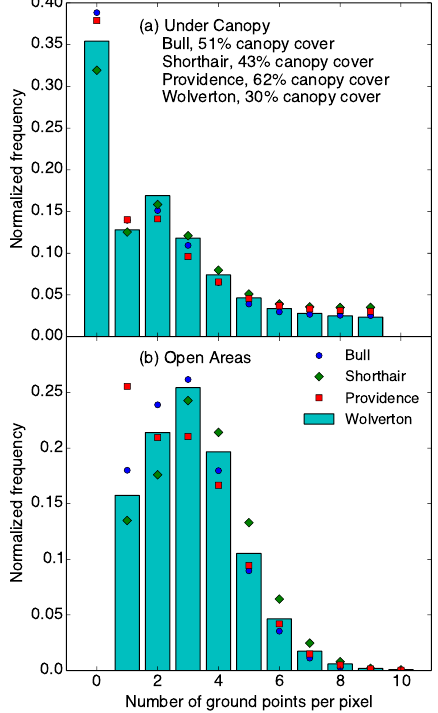
Figure 3. Normalized histogram of the number of ground points for (a) under-canopy and (b) open 1m pixels.